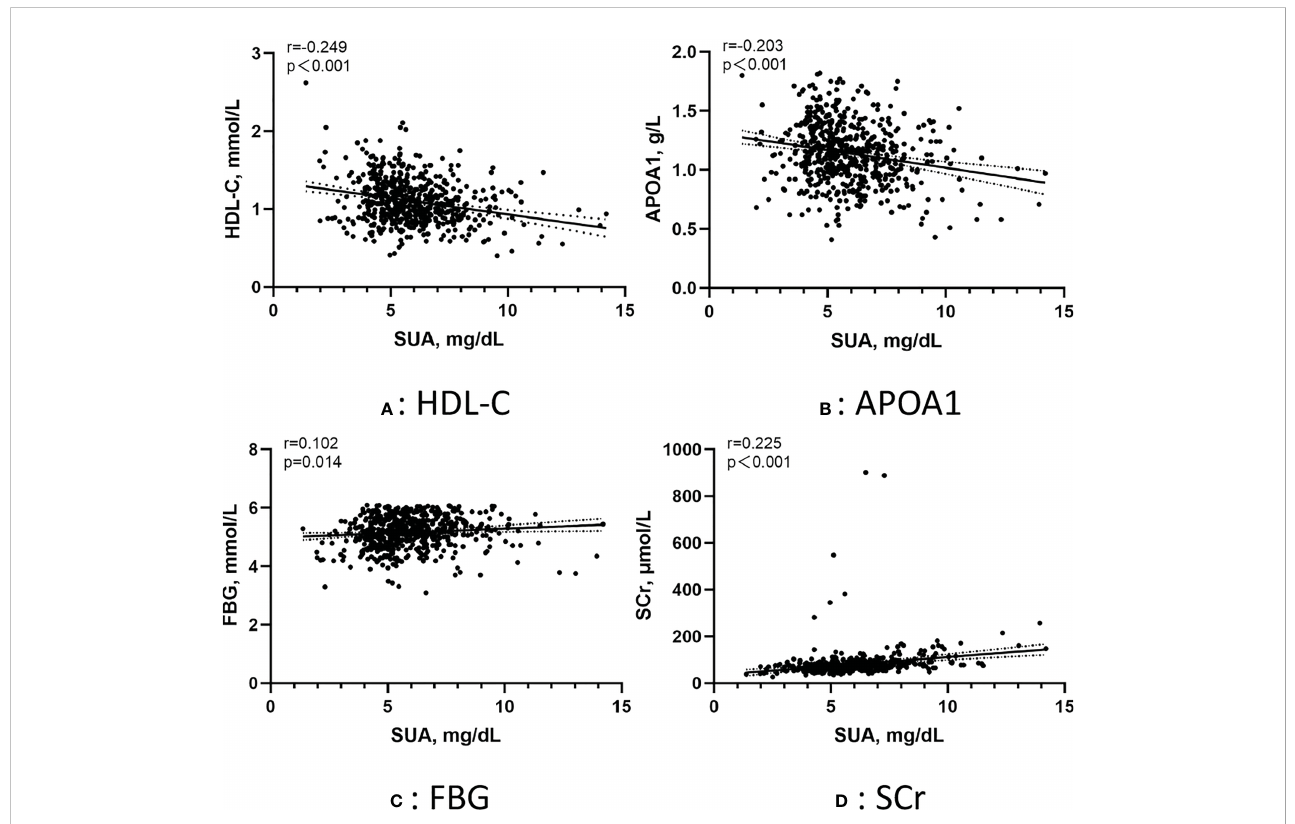
FIGURE 3 Pearson correlation of the SUA in AF patients with metabolic factors under the normoglycemic pattern. (A) Correlation between SUA and HDL-C; (B) Correlation between SUA and APOA1; (C) Correlation between SUA and FBG; (D) Correlation between SUA and SCr. SUA, serum uric acid; HDL-C, high-density lipoprotein cholesterol; APOA1, apolipoprotein A1; FBG, fasting blood glucose; SCr, serum